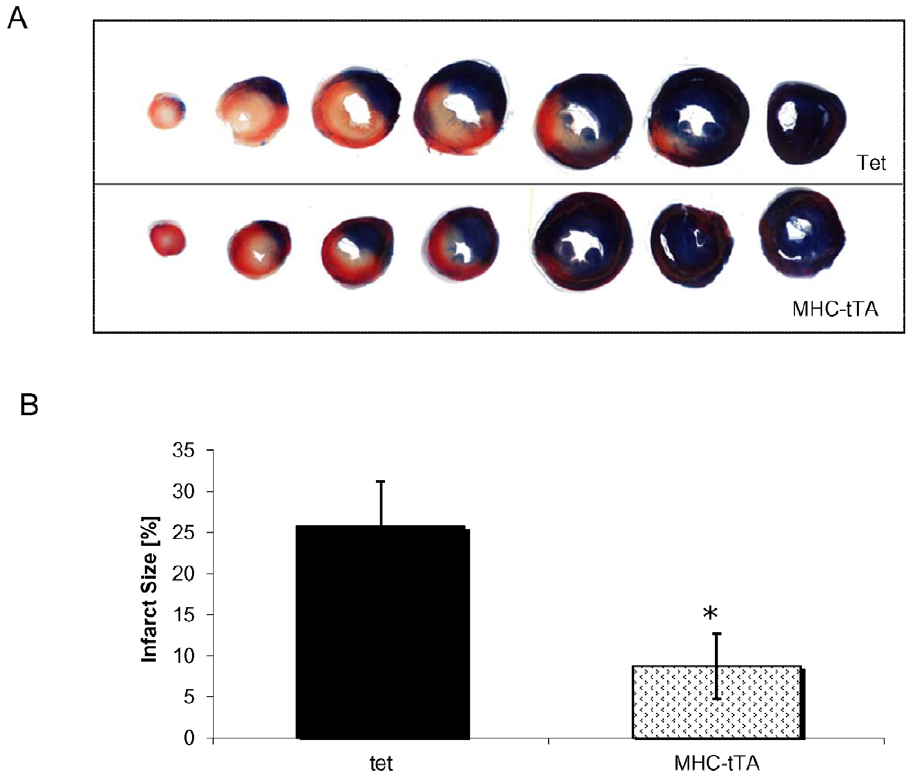
Figure 4. Effect of invivo I/R injury on a -MHC-tTA hearts. Significantly smaller infarct sizes were observed in a -MHC-tTA hearts subjected to 45 min of left coronary artery occlusion followed by 120 min of reperfusion. (A) Representative cross sections from control and a -MHC-tTA hearts. (B) Average infarct size in control and a -MHC-tTA hearts. (N=5 for control and N=7 for a -MHC-tTA, p , 0.05).